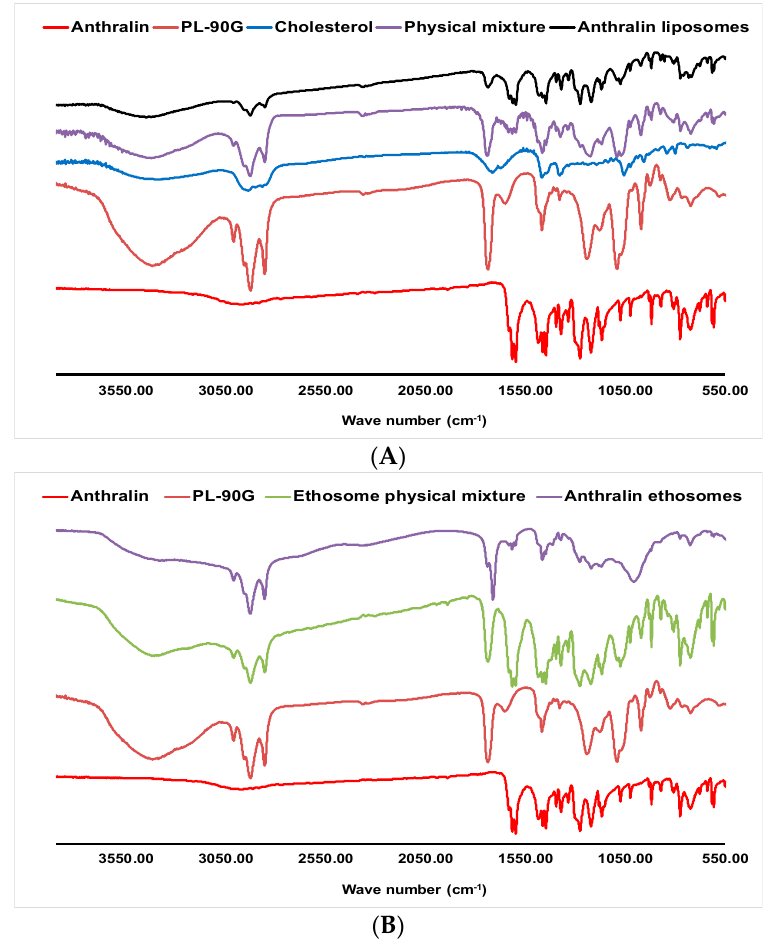
Figure 3. ( A ): Fourier-Transform infrared (FT-IR) spectra of anthralin, PL-90G, cholesterol, liposome physical mixture and anthralin liposomes (L5). ( B ): FT-IR spectra of anthralin, PL-90G, ethosome physical mixture, and anthralin ethosomes (E4).